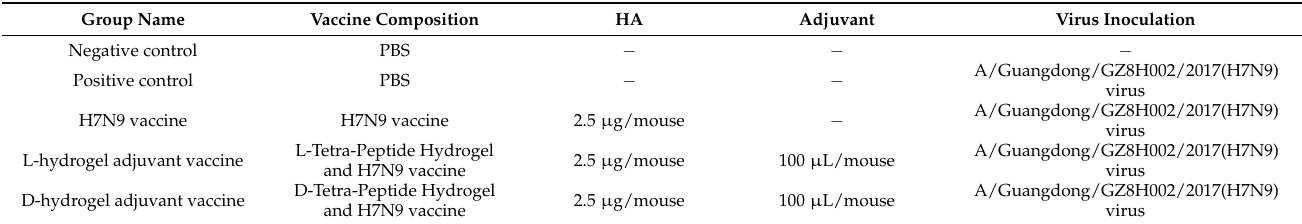
Table 1. Experiment grouping design.